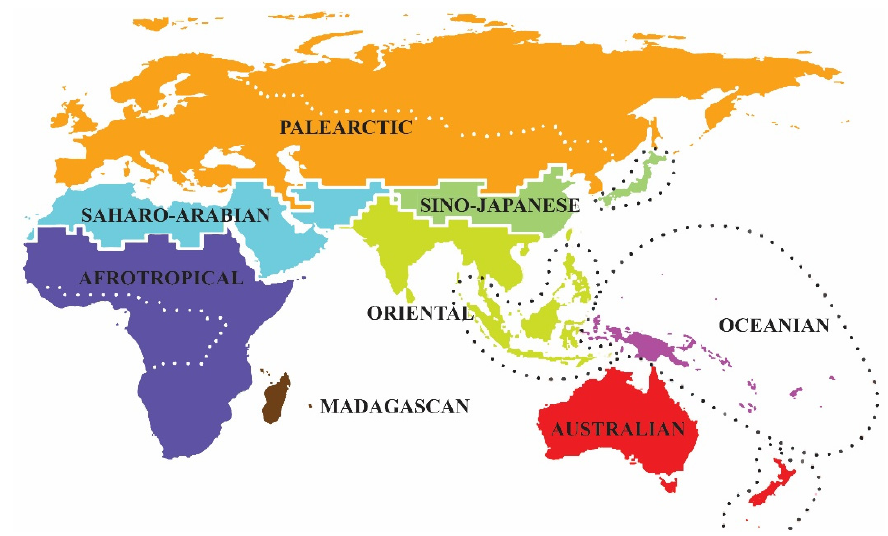
Figure 3. Division of the world zoogeographical regions [24,47].